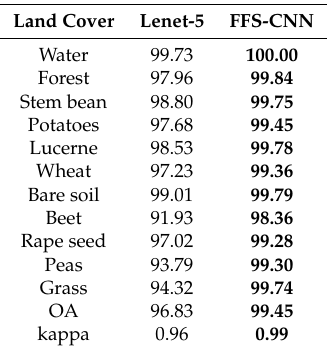
Table 3. The classification accuracies of AIRSAR Flevoland (%).